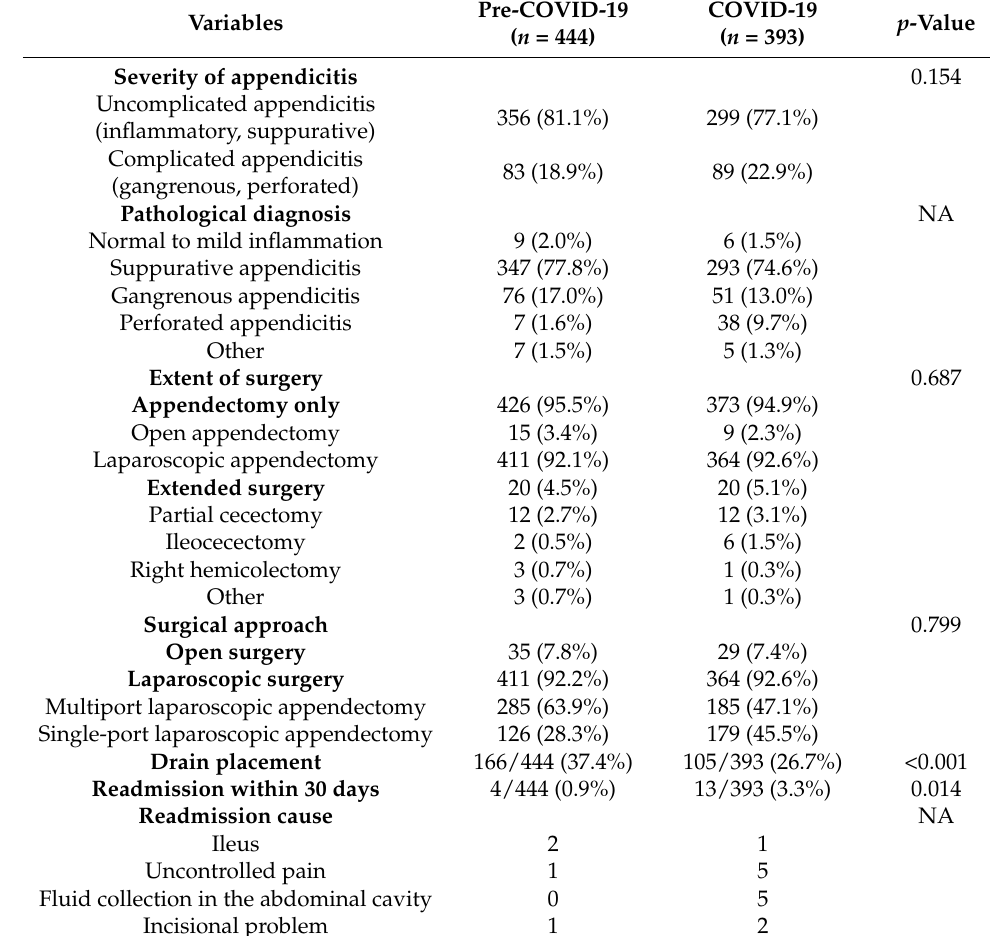
Table 2. Pathological and surgical characteristics of the appendicitis patients.